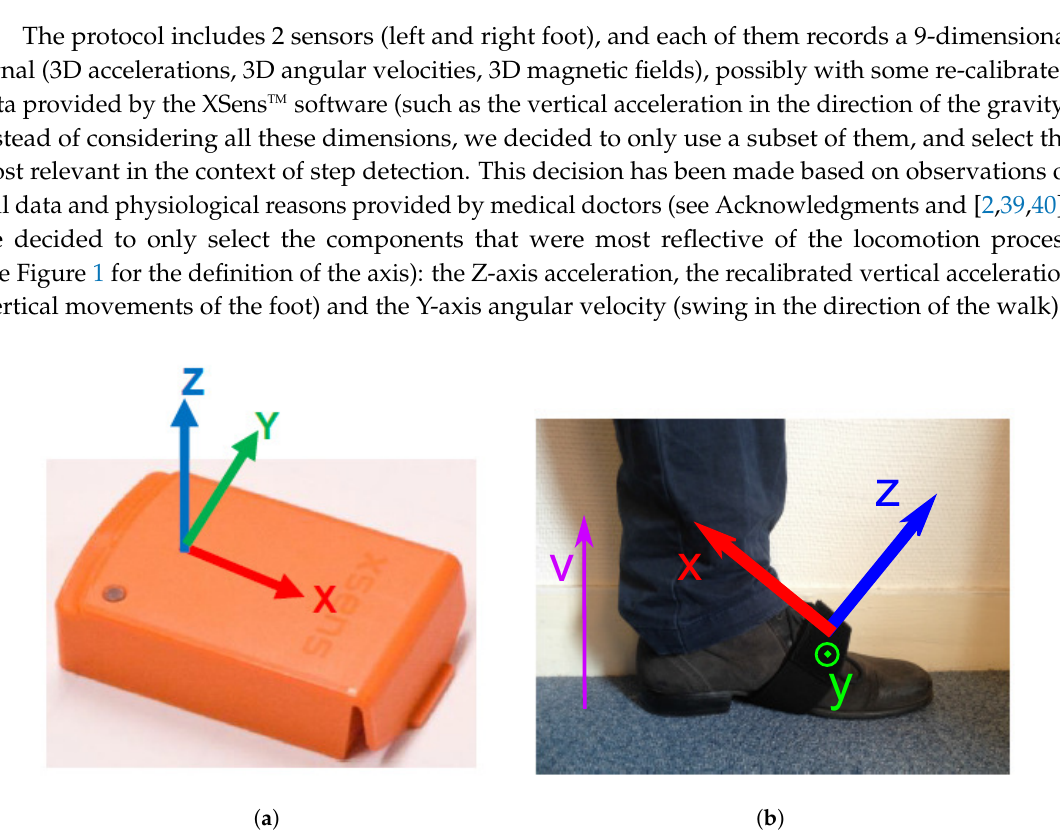
Figure 1. Presentation of the XSens TM sensor. ( a ) XSens TM sensor; ( b ) Definition of the axis for the XSens TM sensor located at the left